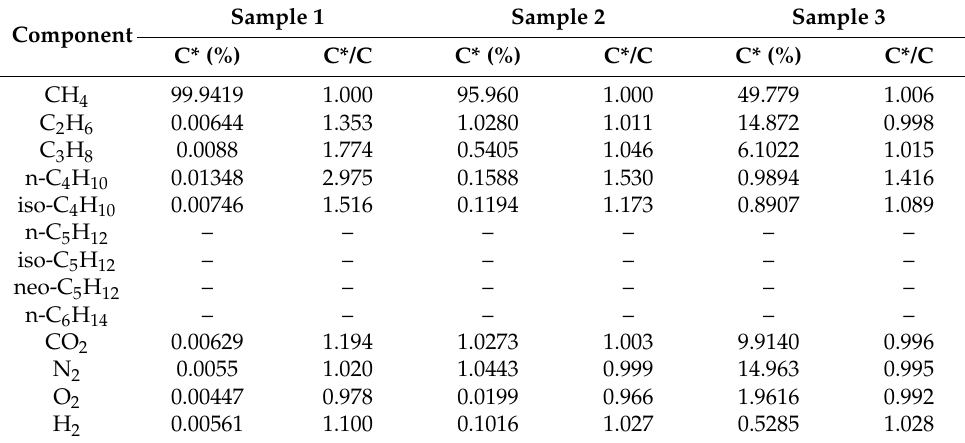
Figure 9. Raman spectra of methane (at 25 and 26.6 atm) and oxygen (at 25 atm). The inset shows that the broadening of the methane lines leads to different intensities in the region where the oxygen band is located. Table 7. The results of the analysis of mixtures, the spectra of which were obtained during the first day of experiments, in the case of ignoring C5+ alkanes. C*/C is the ratio of the concentration obtained by measuring alkanes up to C4 to the concentration obtained by measuring all components (data from Tables